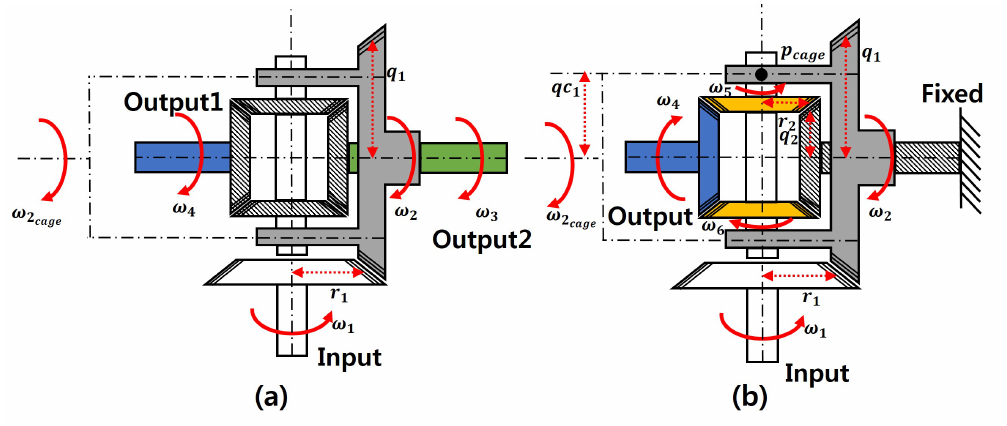
Figure 6. Input–output relation of differential gear mechanism. ( a ) Single input and two outputs. ( b ) Single input and single output.